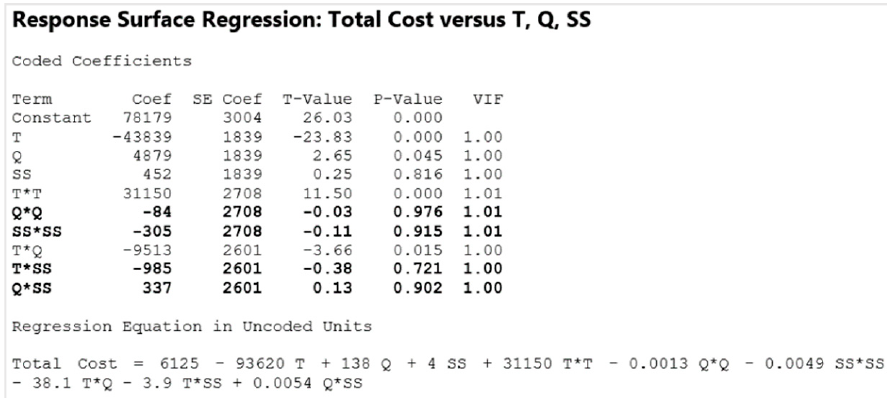
Figure 16. BBD—response surface regression of TC versus T, Q, and SS.